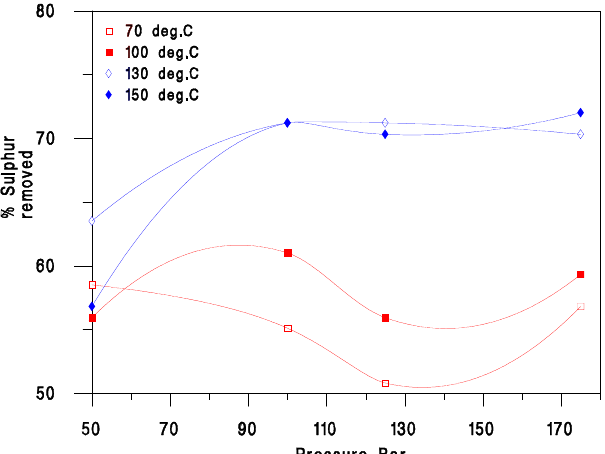
Figure 12. Effect of oxygen partial pressure on organic sulphur removal for Prince of Wales coal.